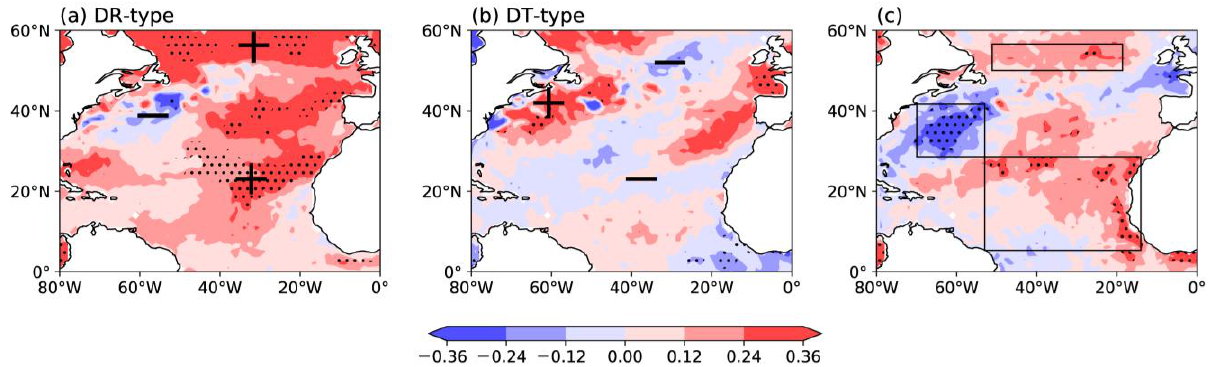
Figure 8. Composite summer SST anomalies (unit: °C) for ( a ) DR-type and ( b ) DT-type. ( c ) Correlation between the CI and summer SST anomalies. The SST anomalies significant at the 90% confidence level are dotted.